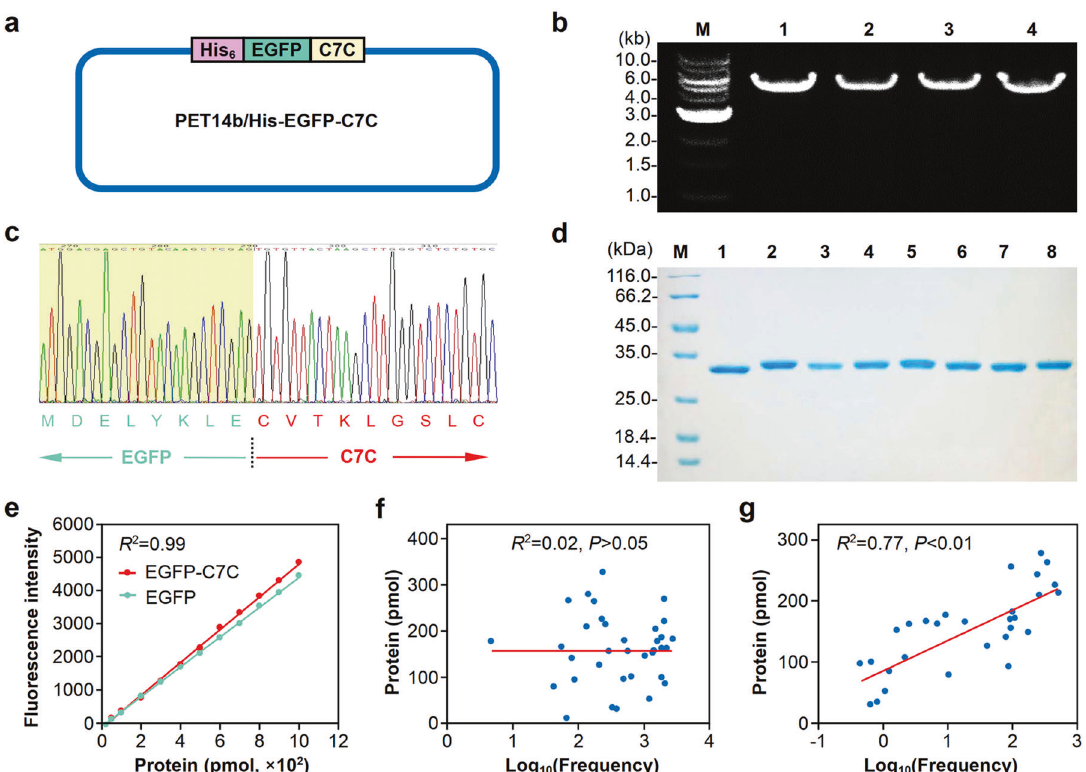
Fig. 5 Validation of binding af fi nity between the heptapeptides and the lethal bacterial strain MSI001 . a Construction of the expression vector for the fusion protein of His-tagged EGFP and heptapeptides. The heptapeptide-encoding DNA sequence was ampli fi ed by PCR and inserted into the expression vector pET14b/His-EGFP to construct the recombinant plasmid expressing His-EGFP-C7C. b Electrophoretogram of PCR products for the construction of plasmids expressing His-tagged EGFP- or EGFP-fused heptapeptides. The PCR products were resolved by electrophoresis on a 1% agarose gel. M represents the DNA marker; lane 1 is the PCR product for pET14b/His-EGFP; lanes 2-4 are PCR products for pET14b/His-EGFP-C7C. c Identi fi cation of plasmids expressing His-EGFP-C7C fusion proteins by DNA sequencing. The DNA sequence for EGFP is indicated with a green arrow, and that for heptapeptide is labeled with a red arrow. d SDS-PAGE of His-tagged EGFP fusion proteins. Puri fi ed fusion proteins, including His-EGFP or His-EGFP-C7C, were resolved by 12% SDS-PAGE. M represents the protein marker; lane 1 is the His-tagged EGFP fusion protein; lanes 2-8 are the His-EGFP-C7C fusion proteins. e Standard curves for fl uorescence intensity and His-tagged EGFP fusion proteins. The fl uorescence intensity was quantitated by spectrophotometry. Formulas were constructed to calculate the amount of His-EGFP or His-EGFP-C7C fusion proteins. f The correlation between heptapeptide frequency and the fl uorescence intensity of the corresponding His-EGFP-C7C fusion proteins. The bacteria were incubated with the His-EGFP-C7C fusion proteins at 25 °C for 4 h, and the fl uorescence of the binding heptapeptides was quantitated by spectrophotometry. The correlation between the log-transformed heptapeptide frequency and the fl uorescence of the corresponding His-EGFP-C7C was analyzed with SPSS (v22). g The correlation between normalized heptapeptide frequency and the fl uorescence intensity of the corresponding His-EGFP-C7C fusion proteins. The binding process and fl uorescence quantitation are described in ( f ). The correlation between the normalized heptapeptide frequency with log transformation and the fl uorescence of the corresponding His-EGFP-C7C was